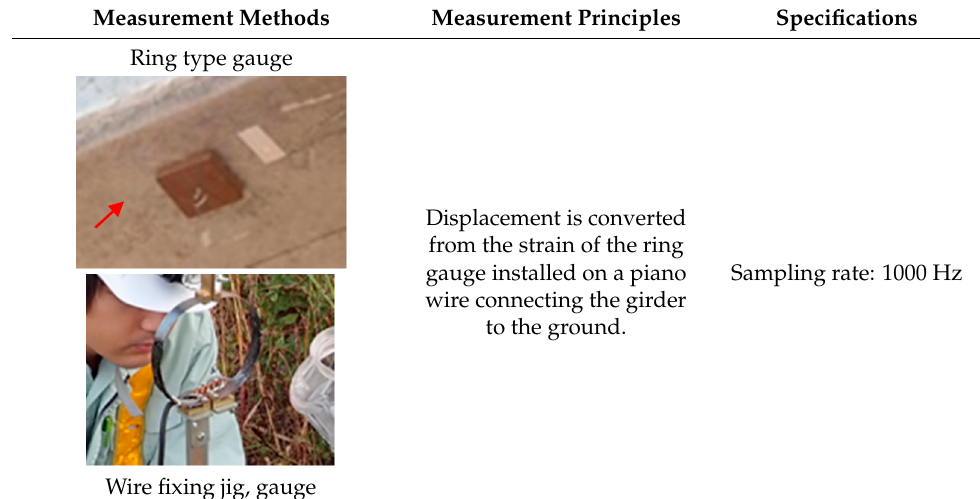
Table 6. Specifications of the measuring equipment on bridge